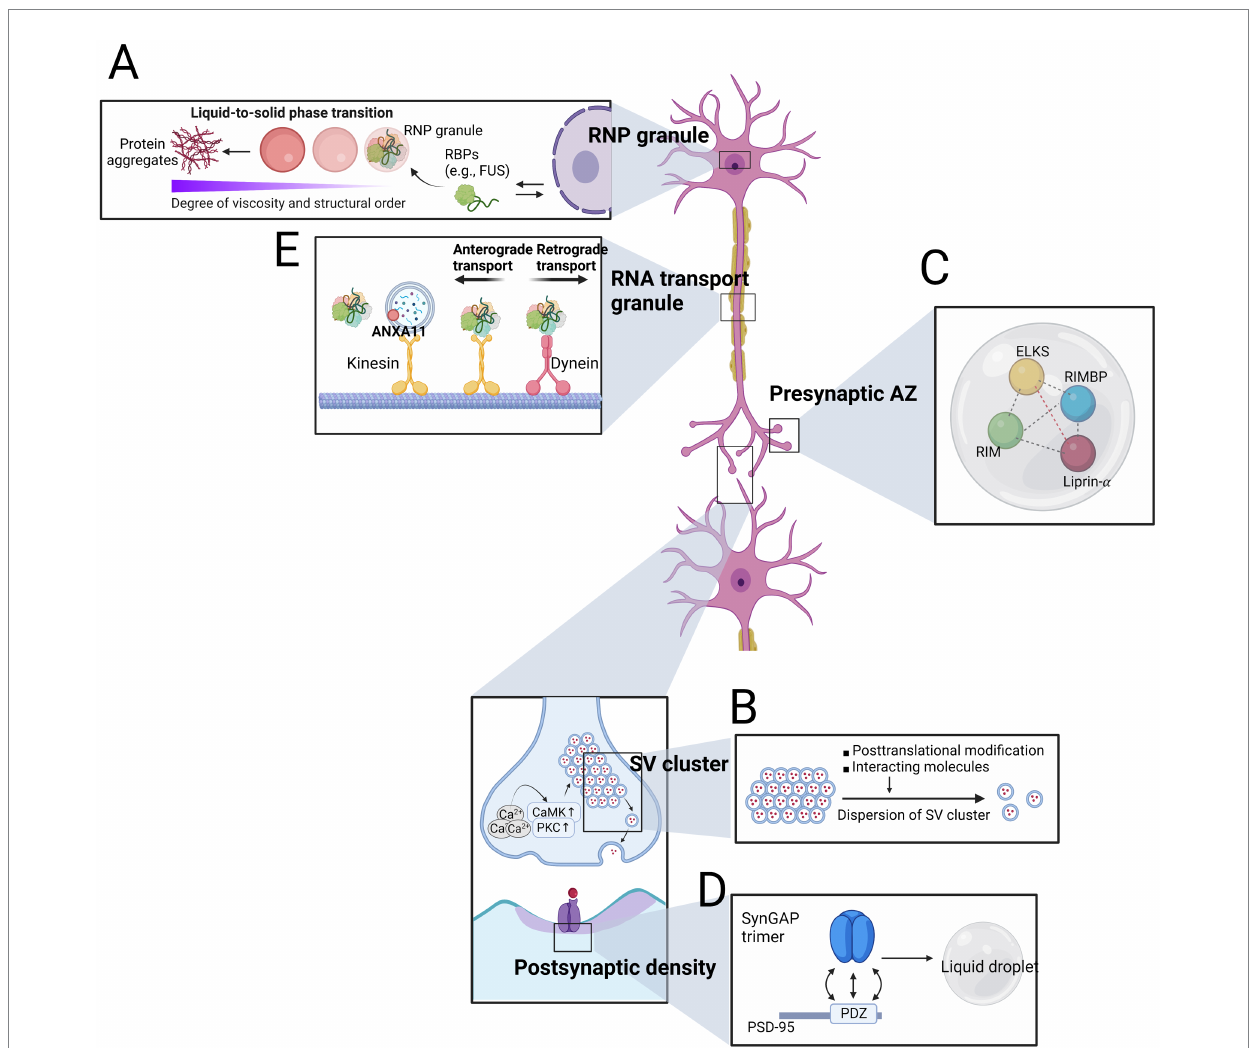
FIGURE 1 Neuronal condensates at the physiologic and pathologic contexts. (A) RNP granules, which are composed of mutant proteins encoded by amyotrophic lateral sclerosis (ALS)–frontotemporal dementia (FTD) causing genes, undergo a phase transition to solid states, resulting in the formation of protein aggregates. (B) Both posttranslational modification such as phosphorylation of synapsin by CaMKII dispersion and changes in interacting molecules (e.g., α -synuclein) lead to the dispersion of synaptic vesicle (SV) cluster. (C) Coexisting phase of scaffolding proteins serve as a hub to accommodate other presynaptic active zones (AZ) proteins. (D) The interaction between SynGAP trimer and PSD-95 plays a crucial role in assembling postsynaptic density. (E) RNA transport granules, either alone or with lysosomes, travel bi-directionally along the microtubule